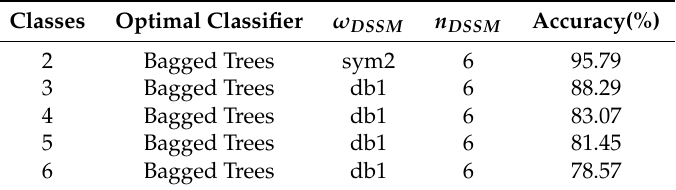
Table 4. The outputs of Algorithm 1.